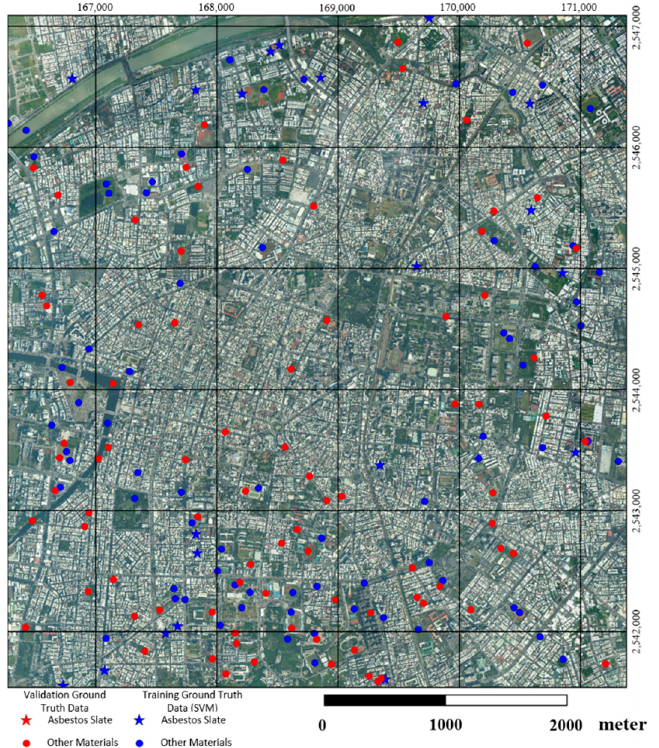
Figure 8. Distributed location of training and validation points for SVM.